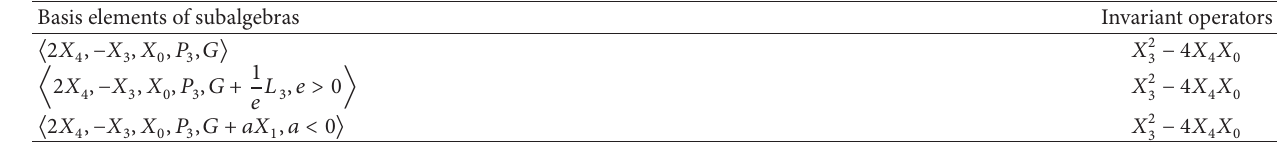
Table 28: Invariant operators of subalgebras of the type 𝐴 5,30 (𝑎 = 0) . Basis elements of subalgebras